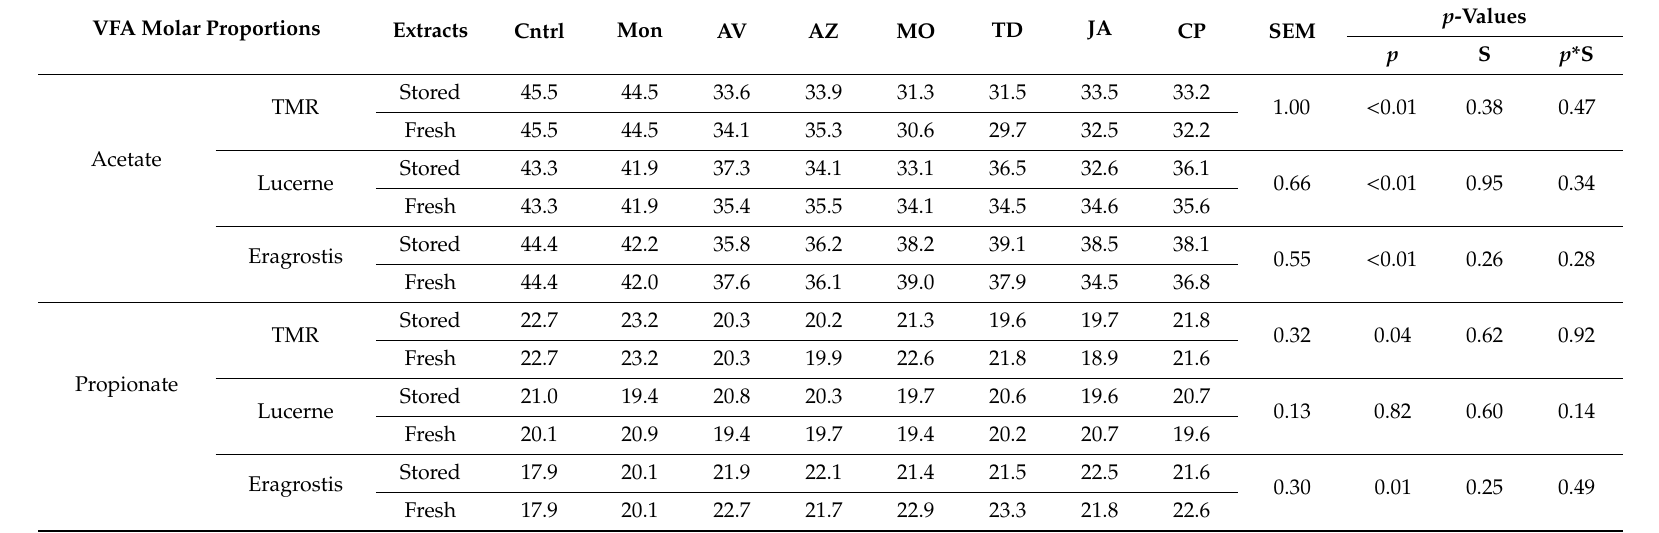
Table 4. Molar proportions of volatile fatty acids from the in vitro incubation of E. curvula , lucerne and TMR substrates from E. curvula , lucerne and TMR substrates incubated with stored or fresh plant